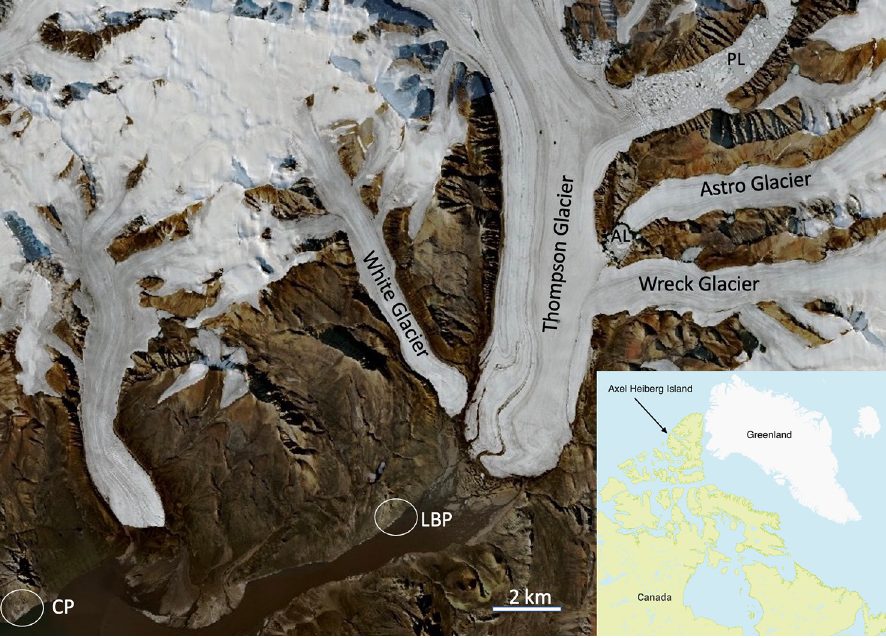
Fig 1. Context image showing the location of Little Black Pond (LBP) and Colour Peak Springs (CP), the glaciers and ice-dammed lakes: Astro Lake (AL) and Phantom Lake (PL). Image from Copernicus Sentinel-2 L2A